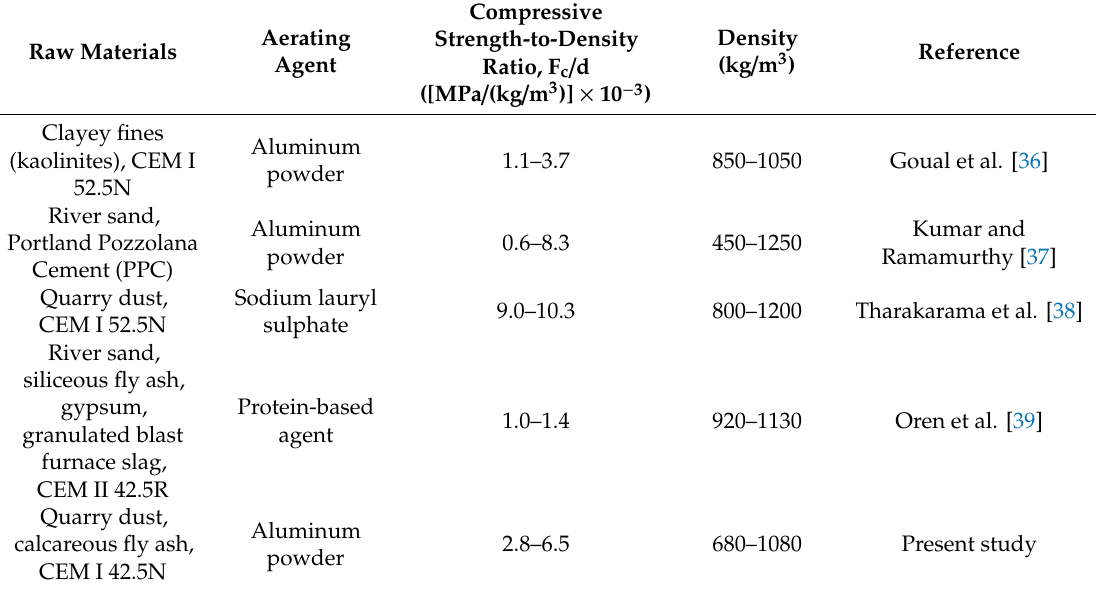
Table 7. Comparison of compressive strength-to-density ratio (F c / d) for moist-cured cellular concrete.